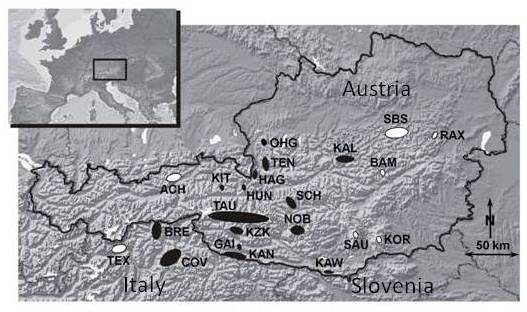
Geographic location of the 22 chamois sampling sites in the Eastern Alps of Austria and the province of South Tyrol (Alto Adige) in Italy. Size and shape of the spots represent rough estimates of the sampled areas. Black spots indicate the 15 localities where scabies outbreaks occurred during the study period. Abbreviations: ACH Achenkirch, BAM District Bruck an der Mur, BRE District Brenner (Italy), COV Corvara (Italy), GAI Gailtaler Alpen, HAG Hagengebirge, HUN Hundstein, KAL Kalkalpen, KAN Karnische Alpen, KAW Karawanken, KIT Kitzbüheler Alpen, KOR Koralm, KZK Kreuzeckgruppe, NOB Nockberge, OHG Osterhorngruppe, RAX Rax, SAU Saualm, SBS District Scheibbs, SCH Schladminger Tauern, TAU Hohe Tauern, TEN Tennengebirge, TEX Texelgruppe (Italy).